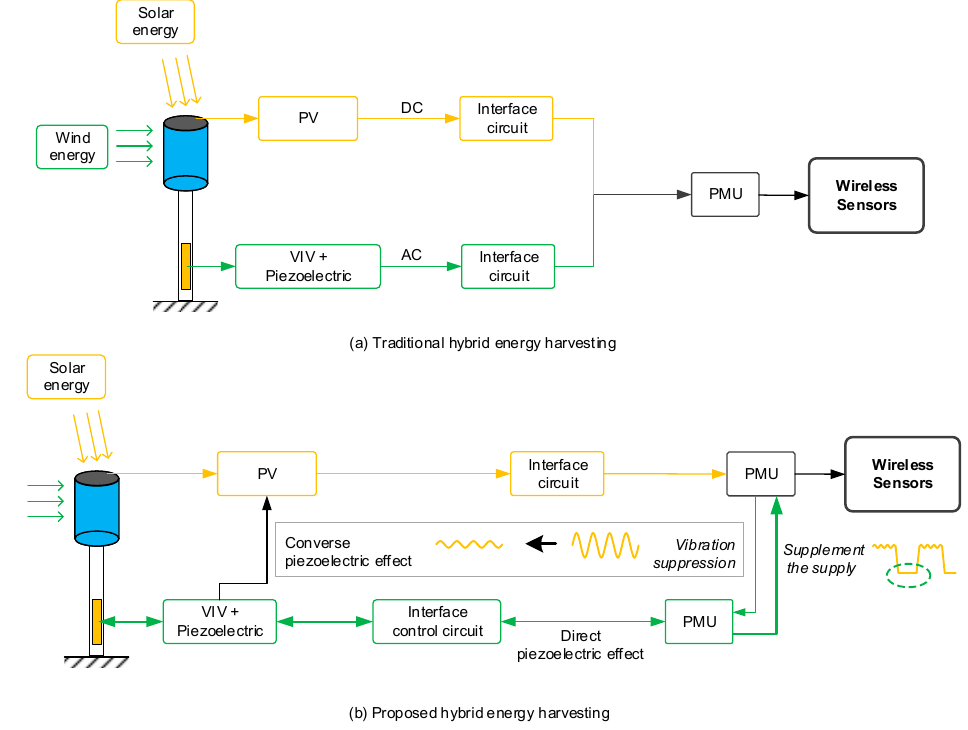
Figure 7. Approach comparison between the traditional and the proposed wind–solar hybrid energy harvesting methods. ( a ) Describes the process of traditional hybrid energy harvesting; ( b ) describes the process of proposed hybrid energy harvesting.